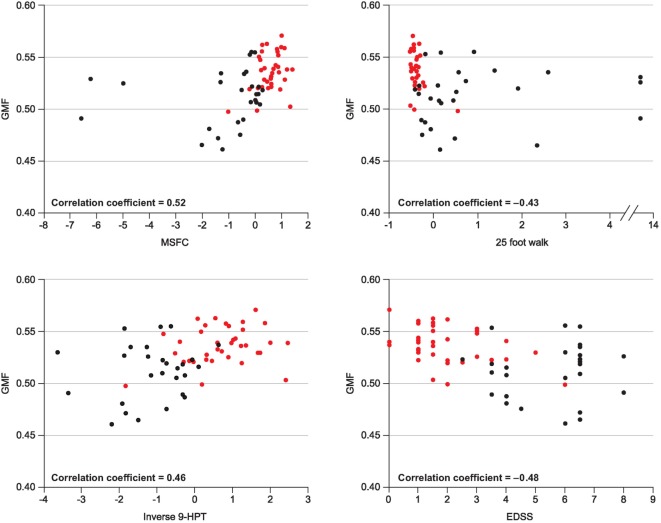
Correlation between GMF and various clinical measures of disability. Republished with permission of John Wiley and Sons Inc, from (79).